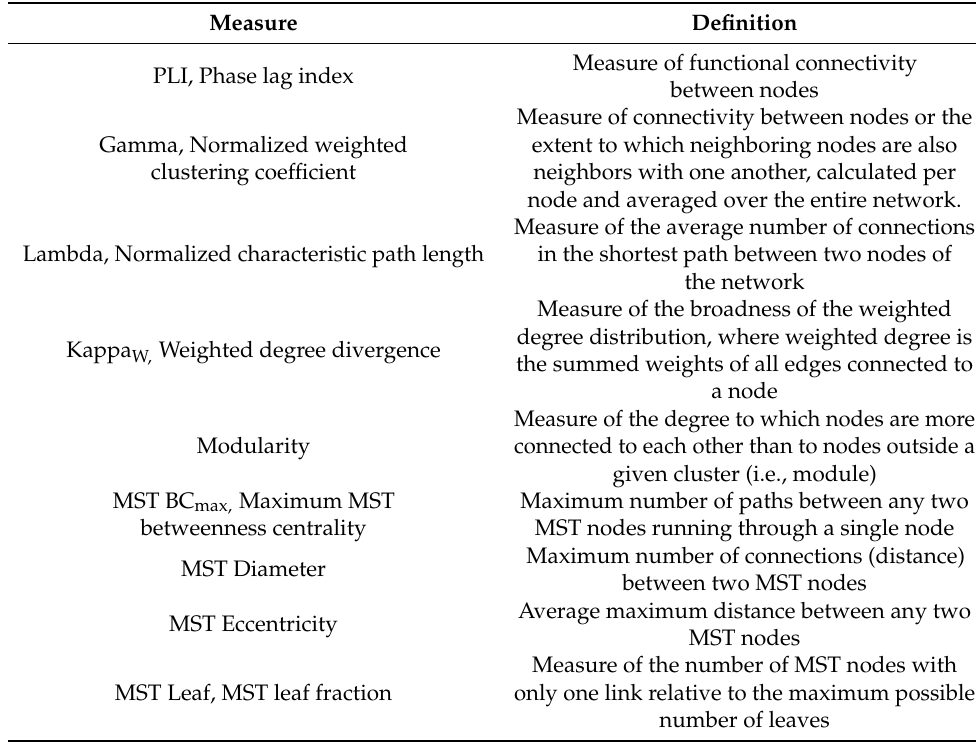
Table 1. Definition of utilized network measures (adapted from Van Steen